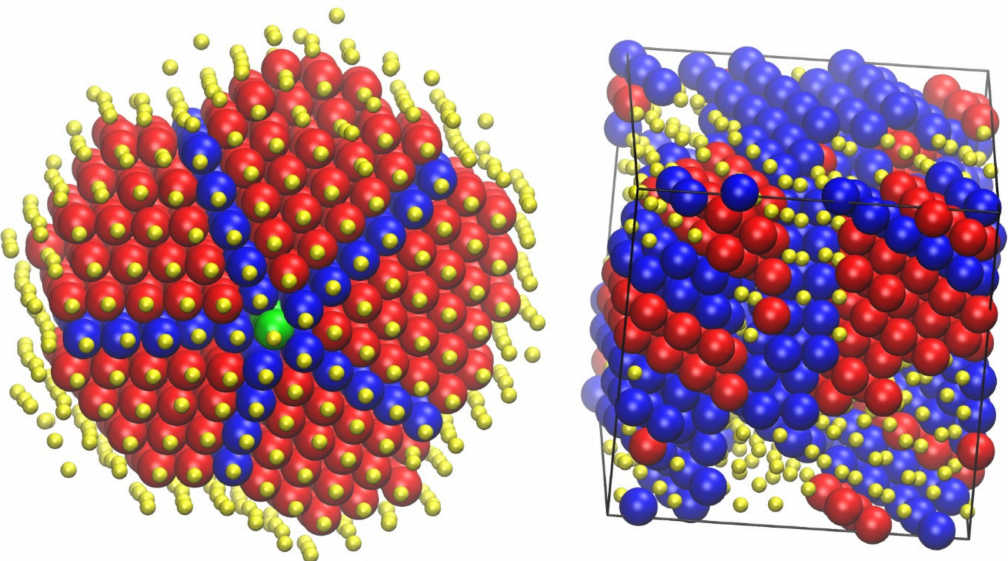
Figure 9. Final configurations of systems whose sites interact with the attractive square well potential. ( Left panel ) NVT simulations on chains ( ε SW = 1.2, σ 2 = 1.15, N = 12, N ch = 100, ϕ = 0.05); ( Right panel ) NPT simulations on monomers ( ε SW = 2.1, σ 2 = 1.15, N at = 1200). Sites are colored according to the CCE norm: Blue, red, green, cyan, and purple correspond to sites with HCP, FCC, FIV, BCC, and HEX similarity, respectively. Amorphous (AMO) sites are colored yellow and shown with reduced dimensions for clarity. Image created with the VMD visualization software [54]. Figure panels are also available as interactive, 3-D images in Supplementary Materials.